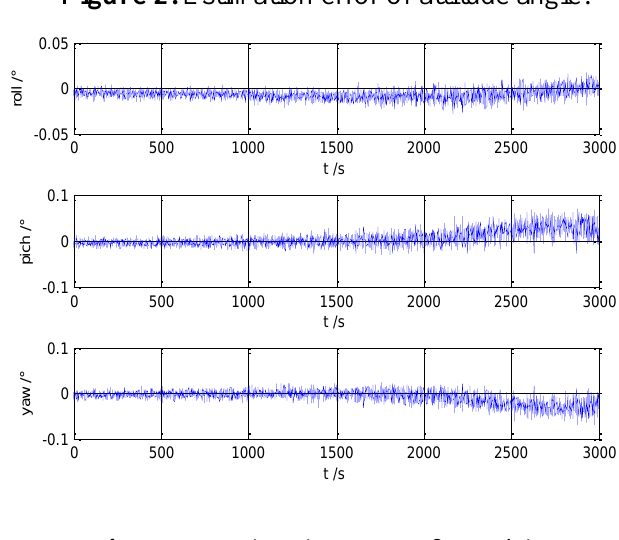
Figure 2. Estimation error of attitude angle.